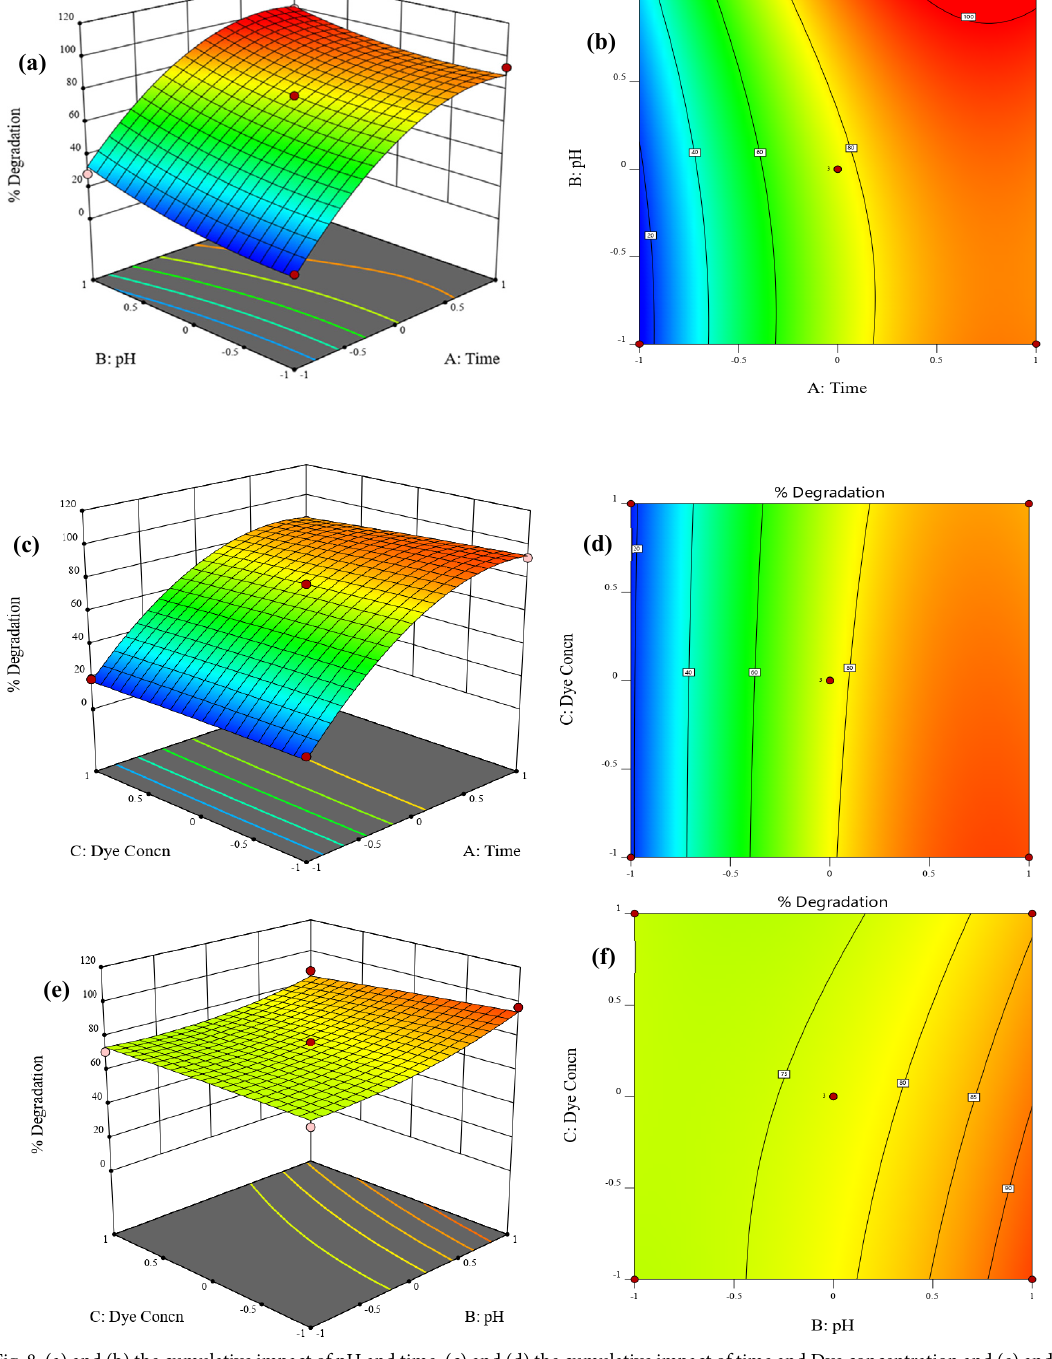
Fig. 8. (a) and (b) the cumulative impact of pH and time, (c) and (d) the cumulative impact of time and Dye concentration and (e) and (f) the cumulative impact of pH and Dye concentration on dye